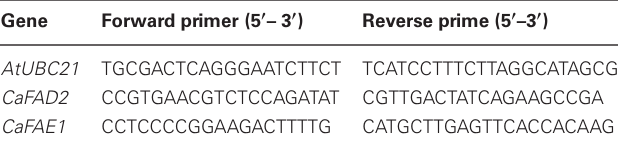
Table 2 | Regeneration results of the hygromycin test on crambe hypocotyls.